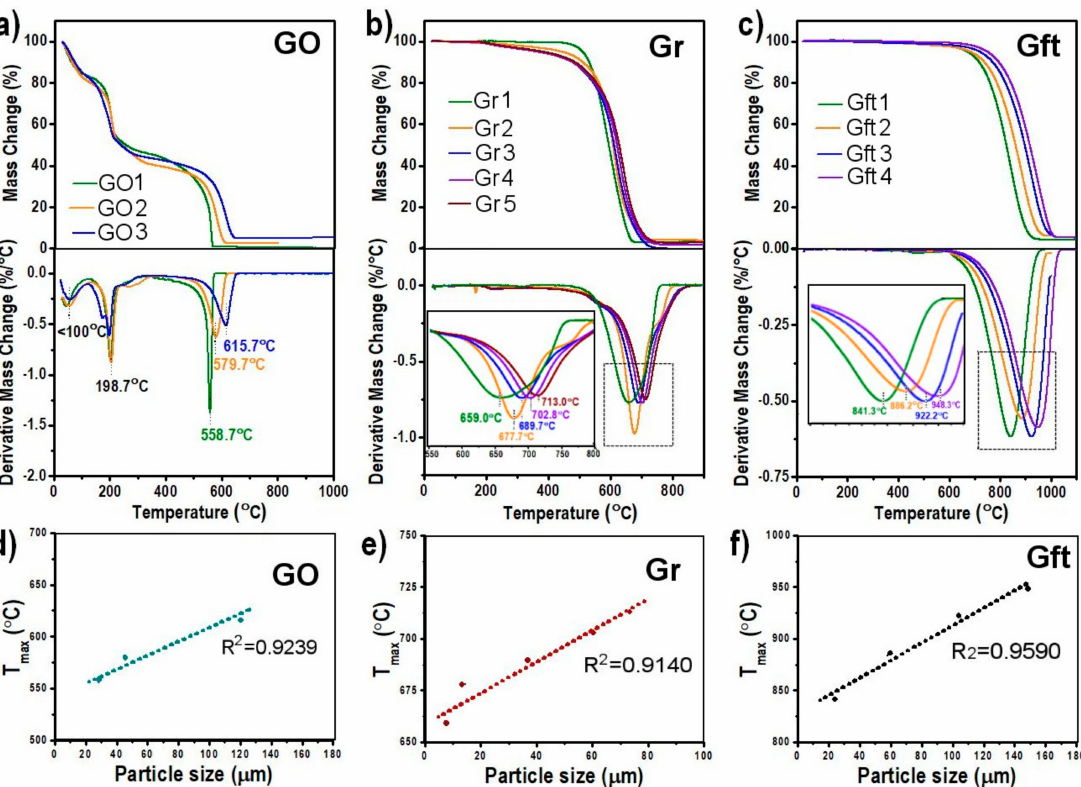
Figure 3. Plots of TGA (top row)-DTG (bottom row) for an array of carbonaceous materials with varied sizes: ( a ) GO, ( b ) grapheme * and ( c ) graphite * samples, showing the T max values derived from their respective DTG peaks in the carbon combustion region. * Inset illustrates closed-up image of rising T max values as particle size of GRMs increased. Plots of T max values vs the median particle size, d(50) v , determined by PSD/LD technique of ( d ) GO, ( e ) Gr and ( f ) Gft